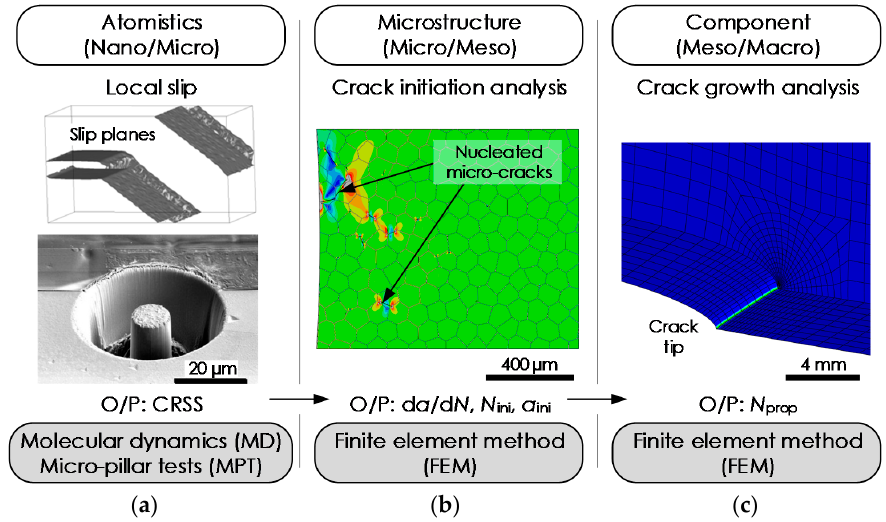
Figure 3. Multiscale approach—coupling of methodologies at the relevant scales and accompanying outputs (O/P). ( a ) Determination of the parameter CRSS either from molecular dynamics (MD) simulations or from micro-pillar tests (MPT). ( b ) Determination of crack growth rate (d a /d N ) and number of stress cycles for crack initiation ( N ini ) from crack initiation analysis. ( c ) Determination of number of stress cycles for crack propagation ( N prop ) [5,8,23,30].